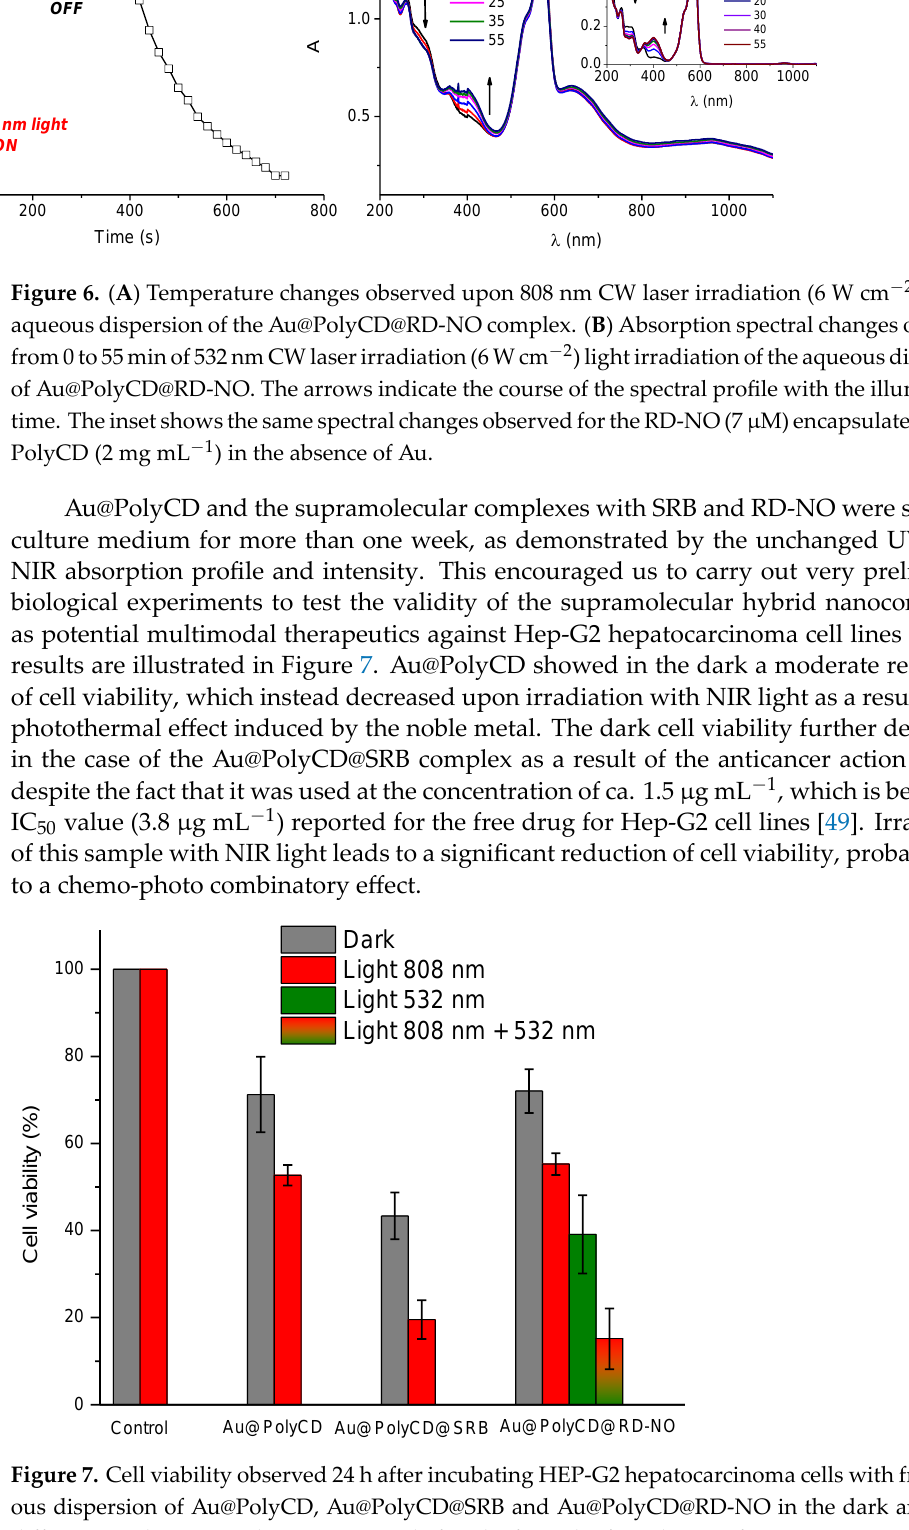
ous dispersion of Au@PolyCD, Au@PolyCD@SRB and Au@PolyCD@RD-NO in the dark and upon different irradiation conditions (occurred after the first 4 h of incubation) for 15 min.